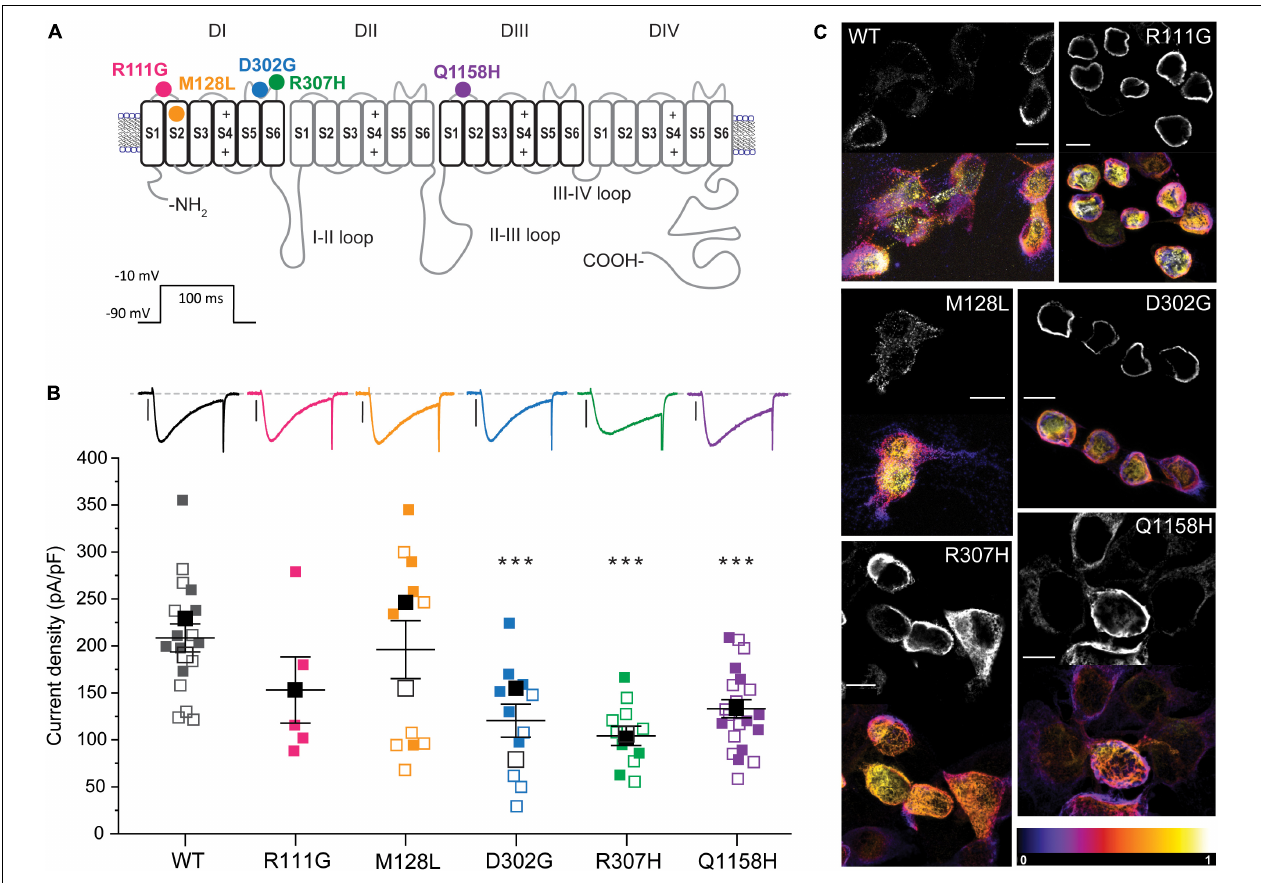
FIGURE 1 | Location and functional expression of Cav3.3 HM-associated variants. (A) Schematic representation of the Cav3.3 channel protein and location of the HM-associated variants functionally characterized. Modular architecture of Cav3.3 showing the four homologous domains (DI–DIV). Each domain is composed of a voltage sensor module (transmembrane segments S1–S4) and a pore module (S5, a re-entrant pore loop and S6). The locations of the amino acids changed by HM-associated rare variants are marked with circles. Color scheme maintained hereafter: R111G ( ), M128L ( ), D302G ( ), R307H ( ), and Q1158H ( ). (B) Top: representative whole-cell currents from Cav3.3 WT and HM-associated variants R111G (fuchsia), M128L (orange), D302G (blue), R307H (green), and Q1158H (purple) expressed in HEK293T cells. Voltage-gated Ca 2 + currents were elicited by a 100-ms pulse to − 10 mV ( V h : − 90 mV, inset). Scale bars: 1 nA. Bottom: summary of current density calculated from peak current amplitude (I peak /cell capacitance in pA/pF). In this and subsequent SuperPlots (Lord et al., 2020), individual values and mean ± SEM (calculated from all data points in each group) are shown. Biological variabilities from independent transfections and recording time points are conveyed by different symbols. Within biological replicates, empty symbols correspond to determinations made 24 h post-transfection ( (cid:3) : mean 24 h), and solid symbols correspond to 48 h post-transfection recordings ( : mean 48 h). The statistical significance was determined through a paired Student’s t -test against Cav3.3 WT. p ≤ 0.001 (***), 0.001 < p ≤ 0.01 (**), or 0.01 < p ≤ 0.05 (*). (C) Confocal micrograph from immunostained Cav3.3 WT and variants (indicated by the corner labels) showing distinct expression patterns. Paired images of Alexa 488 fluorescence of center stack (top) and the depth-encoded full stack sets are shown for each construct. The color scale (bottom right) indicates relative distance from the coverslip. DAPI nuclear stain is not shown here for clarity, see Supplementary Figure 1A . Scale bar 10 microns.